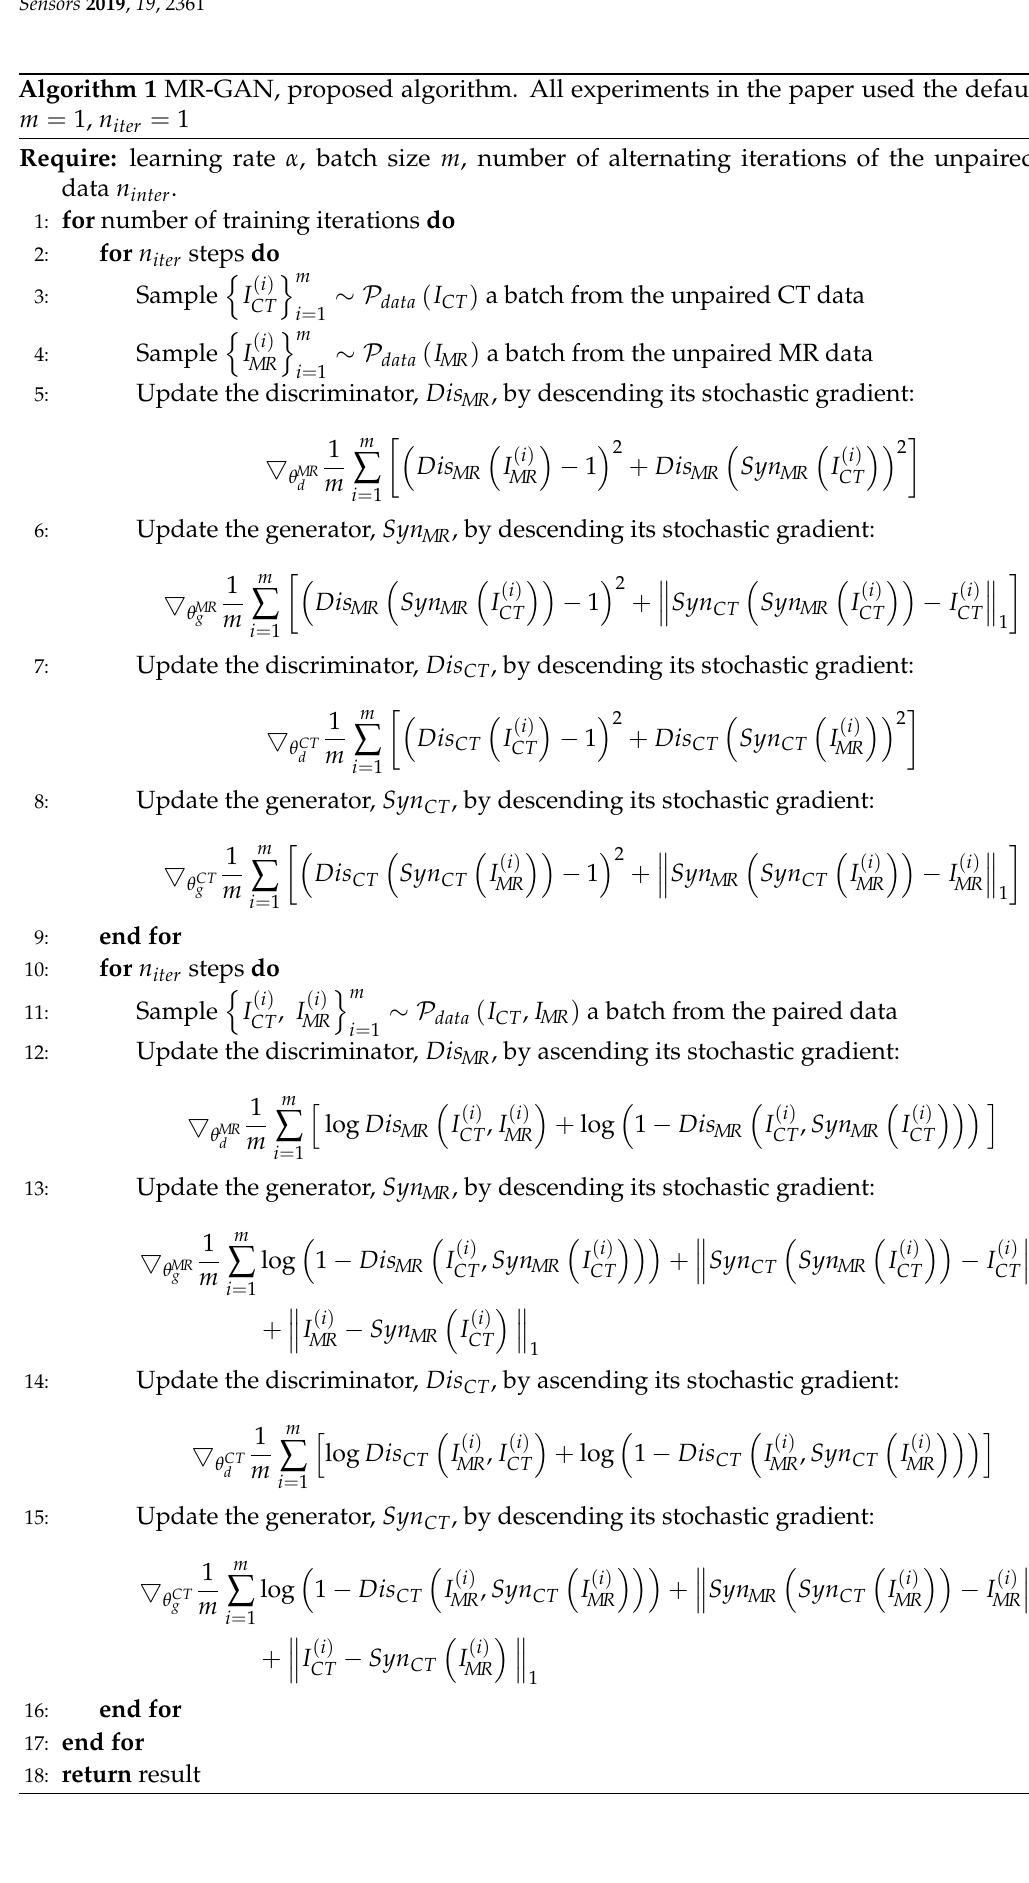
Algorithm 1 MR-GAN, proposed algorithm. All experiments in the paper used the default values m = 1, n iter =